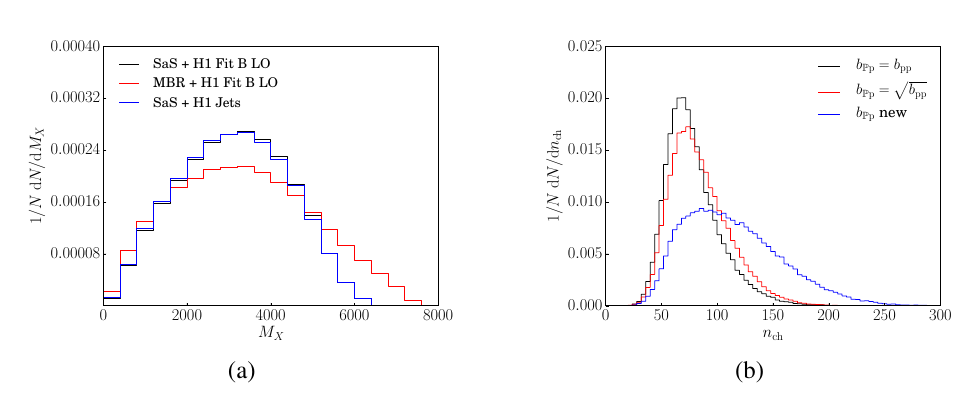
Figure 2. (a) The mass of the di ff ractive system, M X , when changing P parametrization. (b) The number of charged particles in the P p system, when changing the size of the P